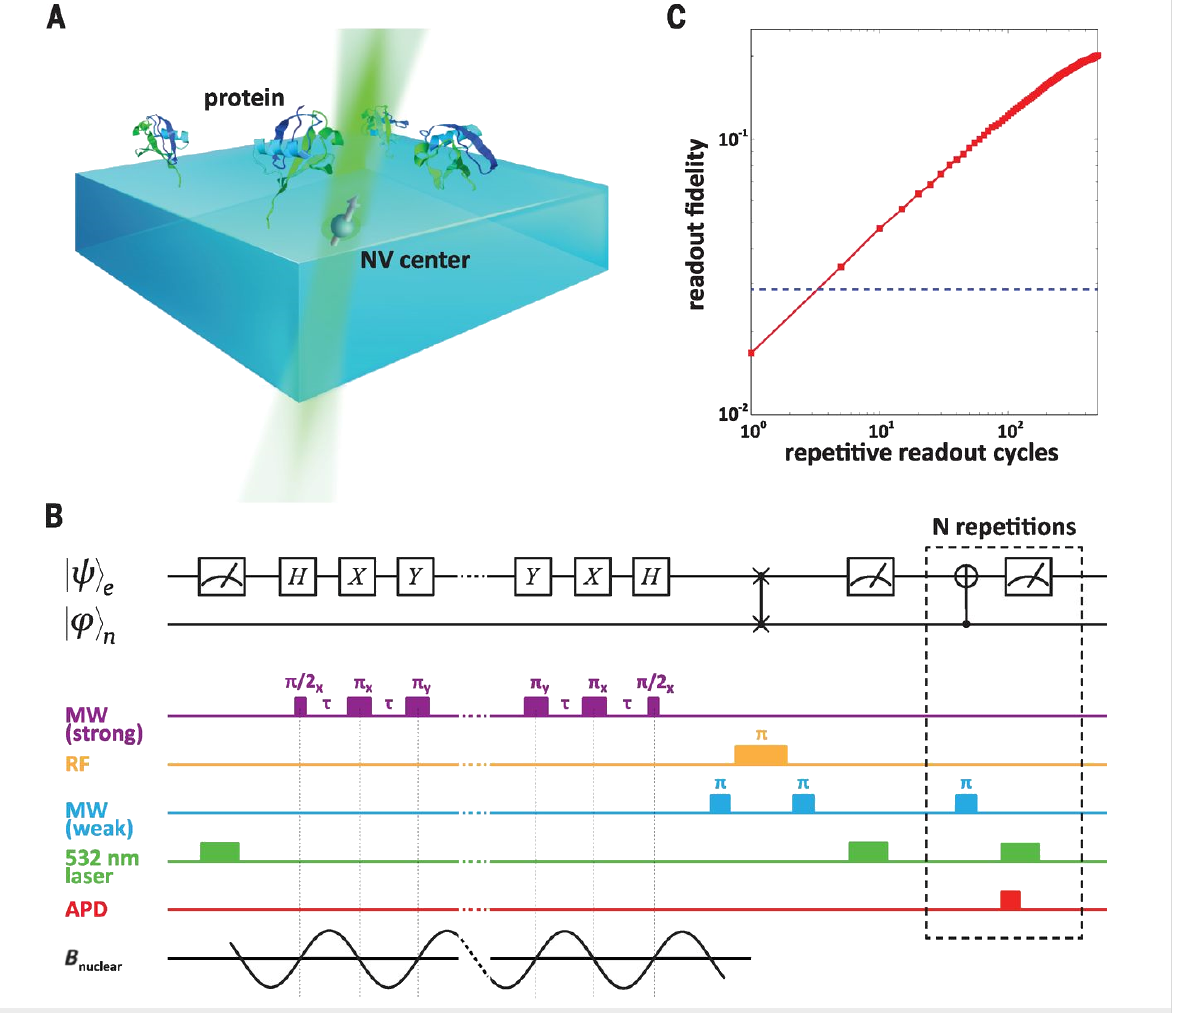
Figure 5: Experimental setup and magnetometry with repetitive readout [78]. Image reprinted with permission from [78], copyright 2016 AAAS. (A) Ex- perimental setup. NV center electronic spin and its associated 15 N nuclear spin are used as a proximal quantum sensor to probe ubiquitin proteins on the surface of the diamond. (B) Quantum circuit diagram and experimental magnetometry pulse sequence. (C) Repetitive readout cycles and measured fidelity gain. MW – microwave; RF – radiofrequency; APD – avalanche photodiode; B – nuclear spin magnetic